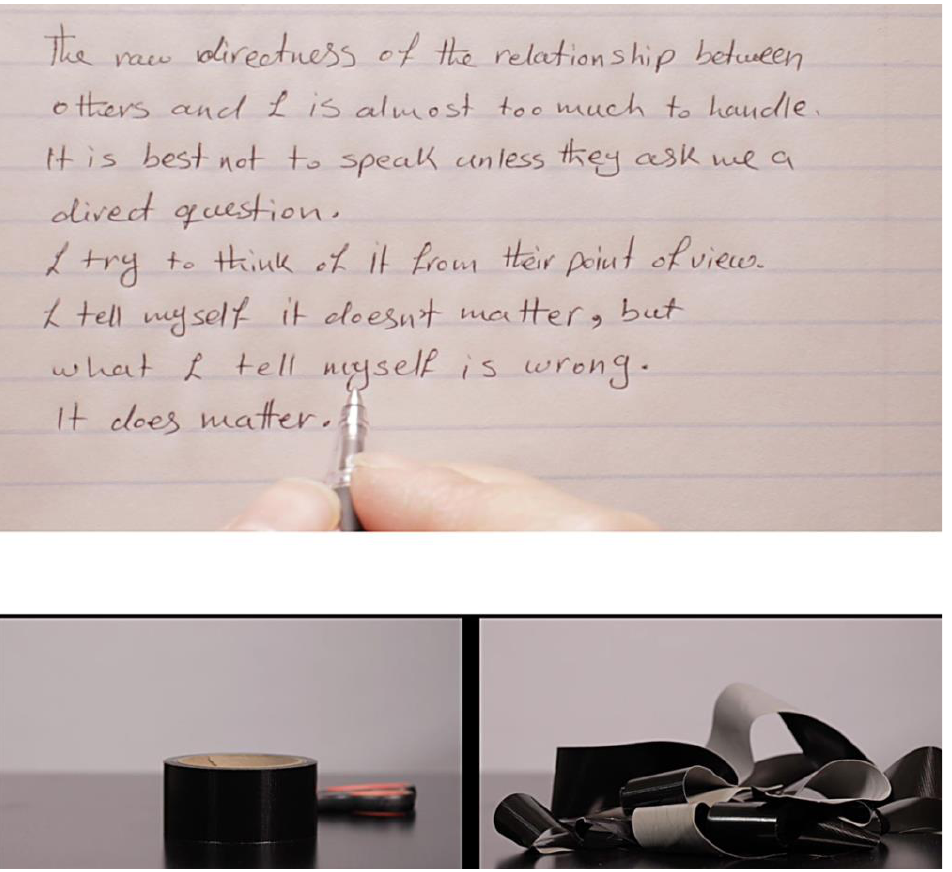
Sepideh Tajalizadeh Dashti, Untitled, 2019. Installation (two channel video, sound,